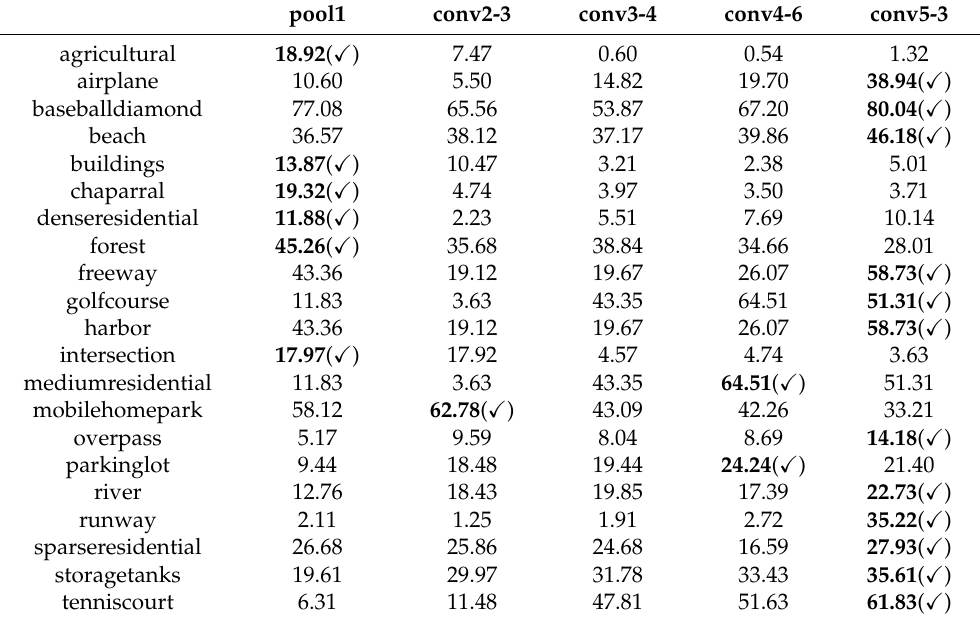
Table 3. wPO(%) of each layer from ResNet-50 on